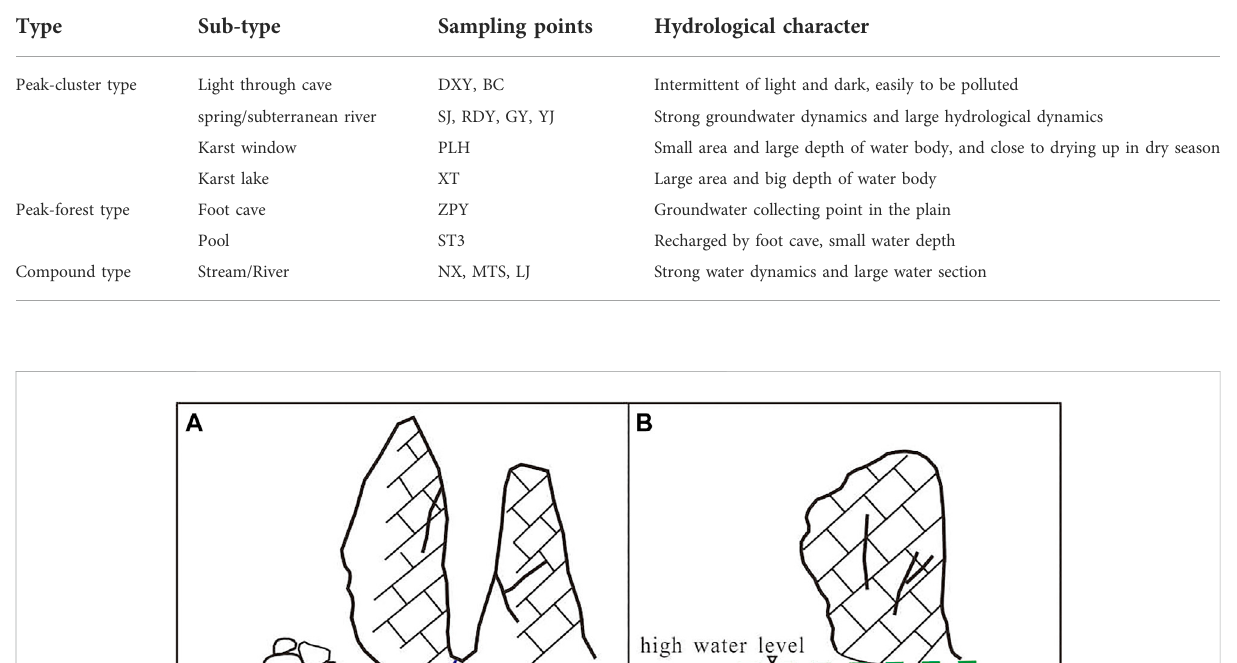
TABLE 2 Diversity of the studied wetlands and their hydrological character.